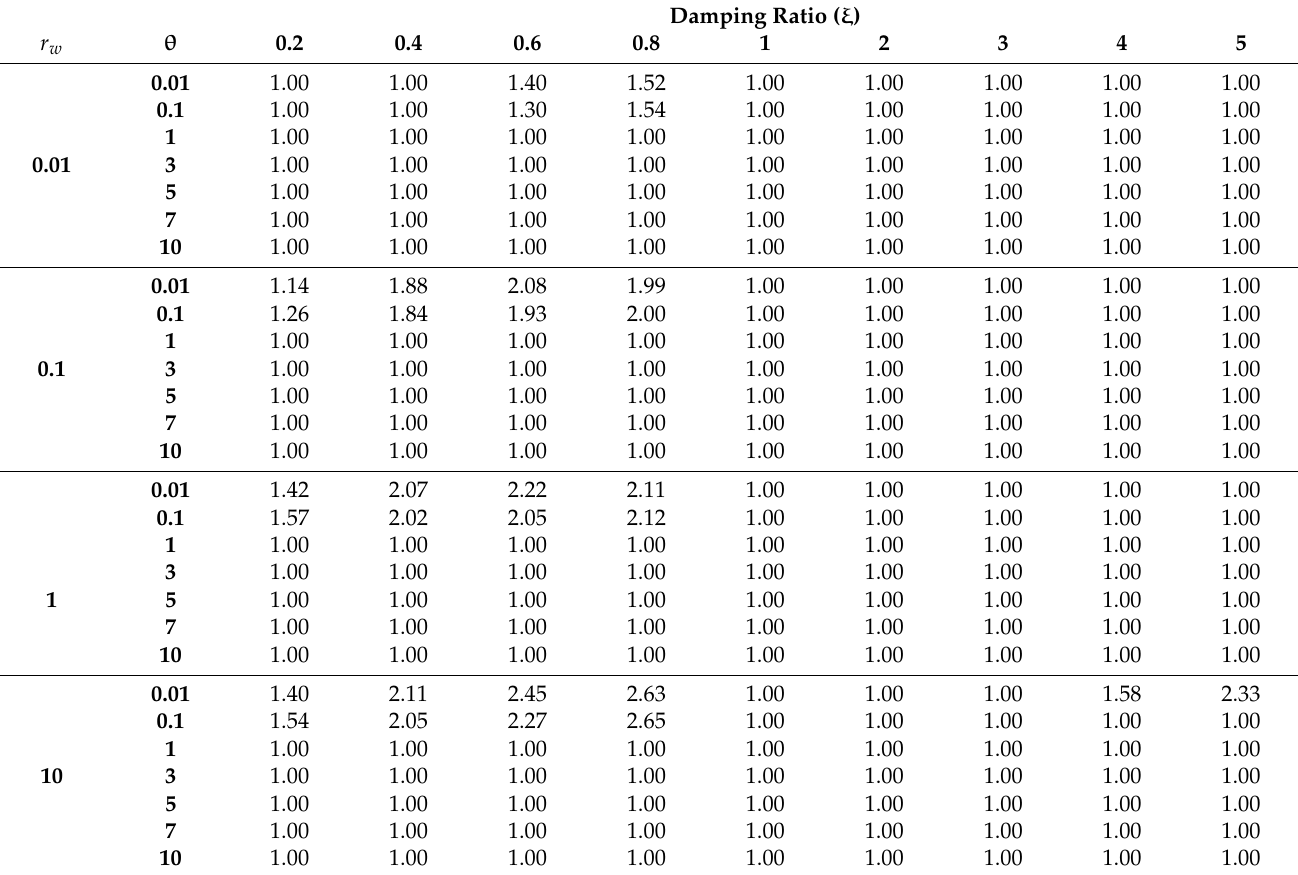
Table 12. Normalized IAE for MPC (Process 4, Setpoint response).